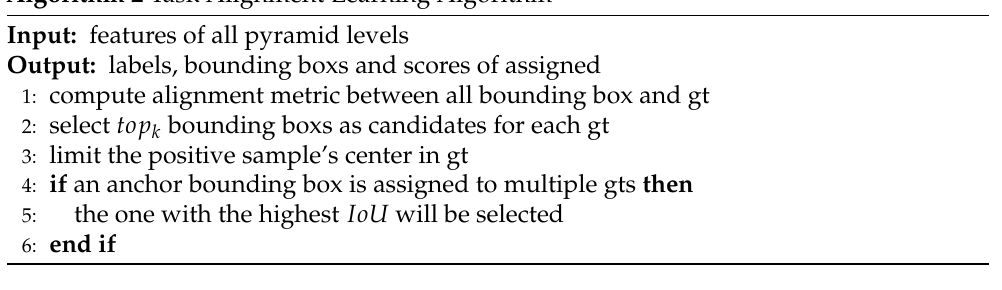
Algorithm 2 Task Alignment Learning Algorithm